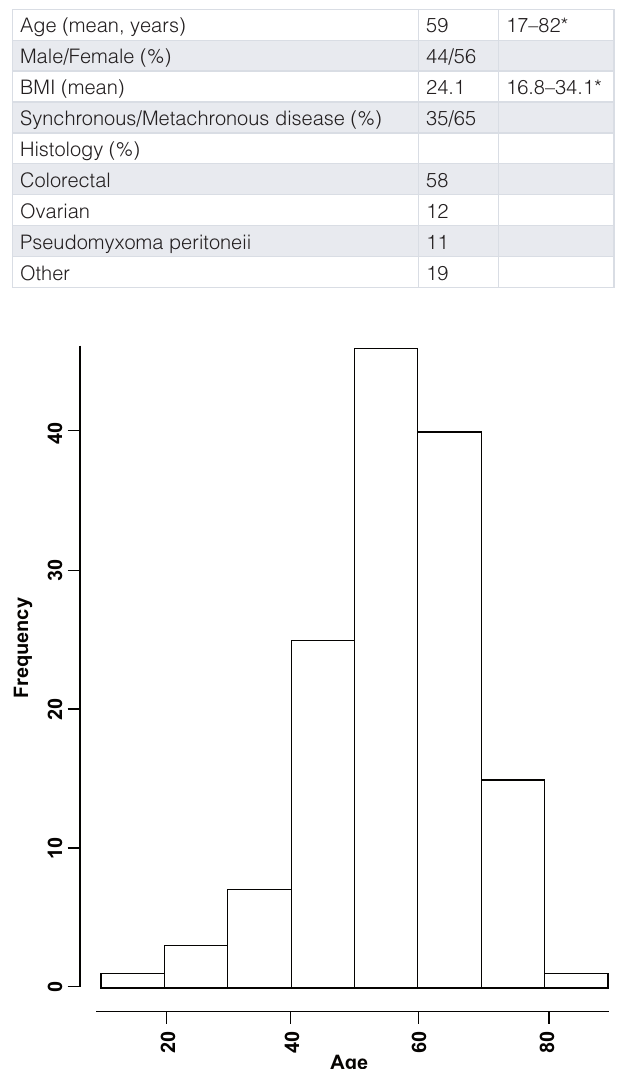
Table 1. Demographic details of 138 patients treated with oxaliplatin based HIPEC (*:minimum-maximum).